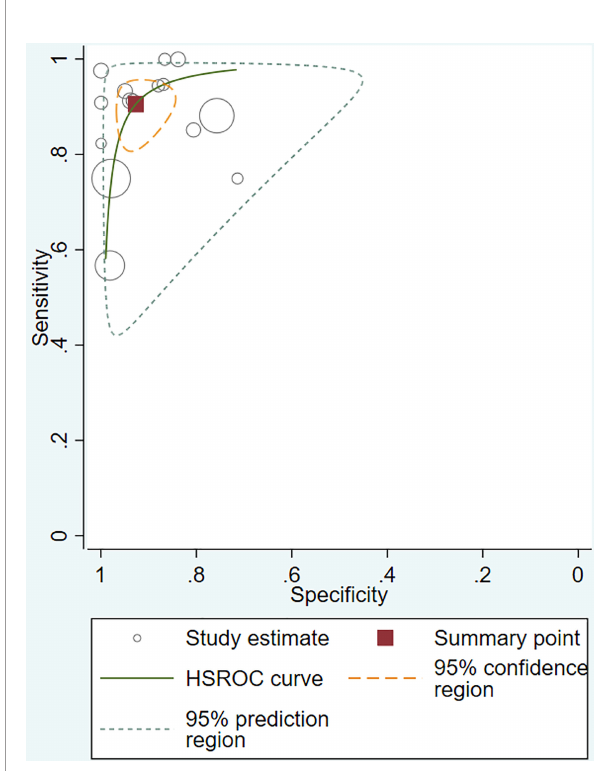
FIGURE 7 | Pooled hierarchical summary receiver operating characteristic (HSROC) curves.